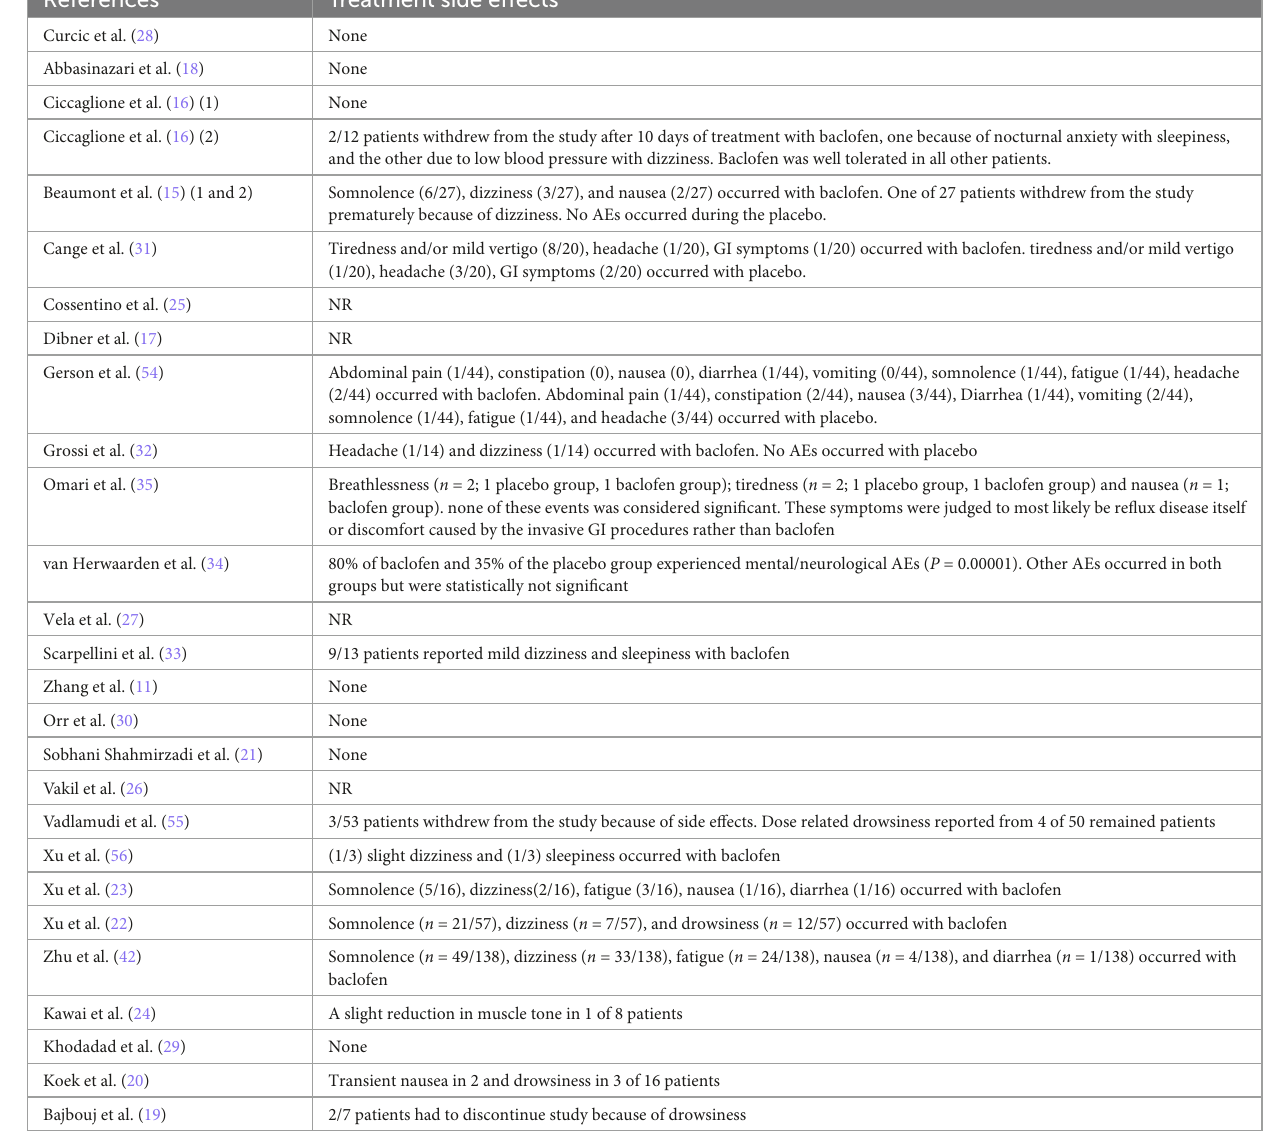
TABLE 4 Treatment safety and side